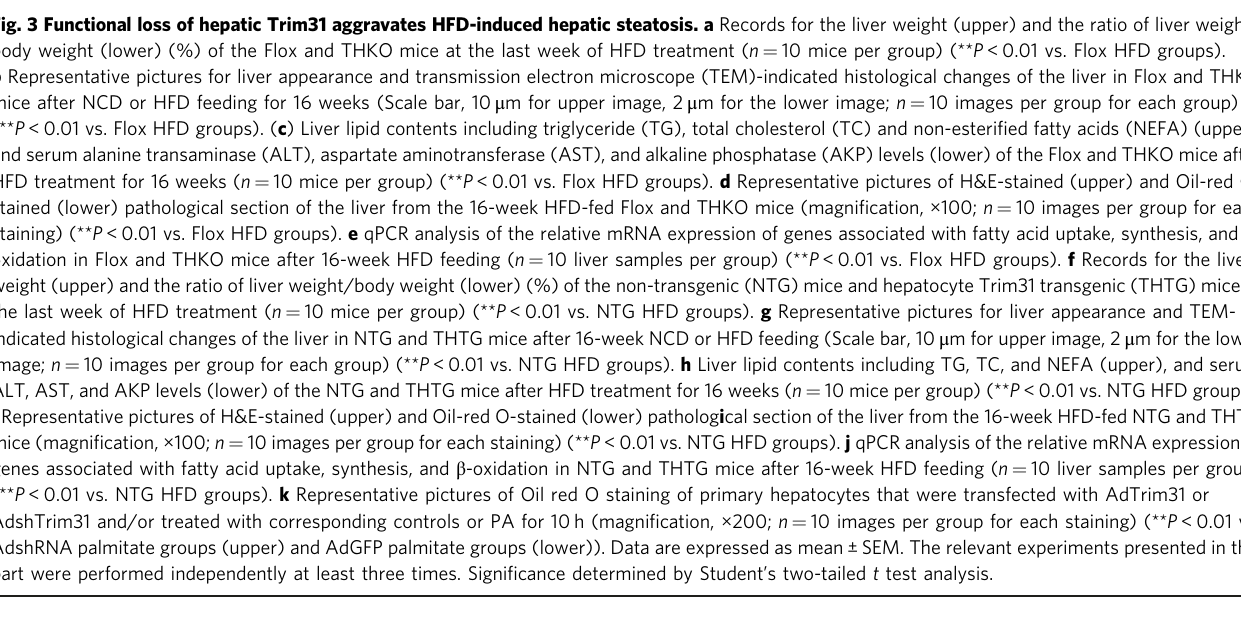
Fig. 3 Functional loss of hepatic Trim31 aggravates HFD-induced hepatic steatosis. a Records for the liver weight (upper) and the ratio of liver weight/ body weight (lower) (%) of the Flox and THKO mice at the last week of HFD treatment ( n = 10 mice per group) (** P < 0.01 vs. Flox HFD groups). b Representative pictures for liver appearance and transmission electron microscope (TEM)-indicated histological changes of the liver in Flox and THKO mice after NCD or HFD feeding for 16 weeks (Scale bar, 10 μ m for upper image, 2 μ m for the lower image; n = 10 images per group for each group) (** P < 0.01 vs. Flox HFD groups). ( c ) Liver lipid contents including triglyceride (TG), total cholesterol (TC) and non-esteri fi ed fatty acids (NEFA) (upper), and serum alanine transaminase (ALT), aspartate aminotransferase (AST), and alkaline phosphatase (AKP) levels (lower) of the Flox and THKO mice